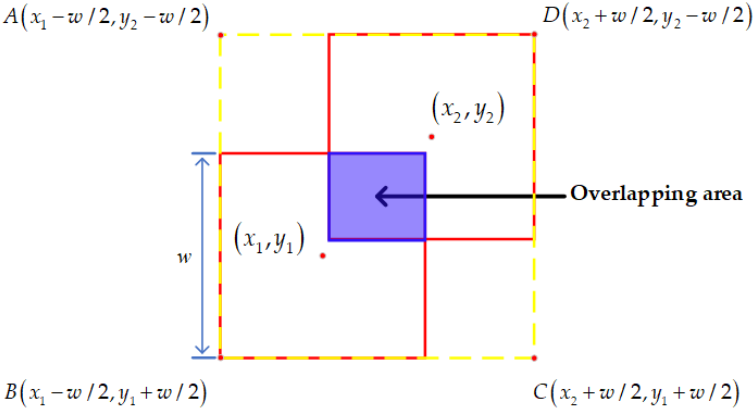
Figure 4. Template merging diagram.